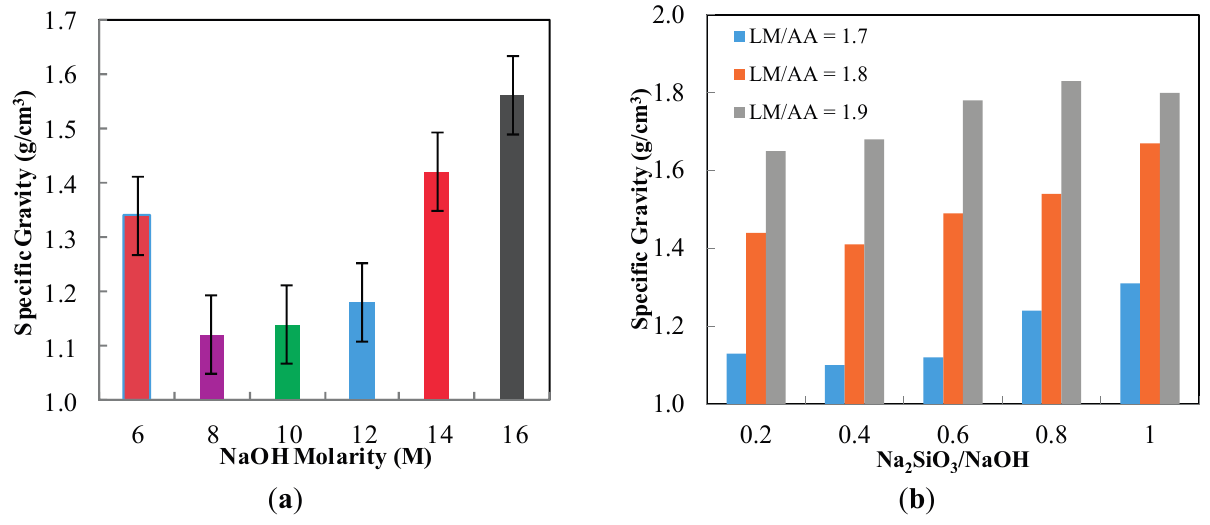
Figure 1. The specific gravity of ALGA at ( a ) various NaOH molarity; ( b ) various LUSI mud/Alkaline activator (LM/AA) ratio and Na 2 SiO 3 /NaOH